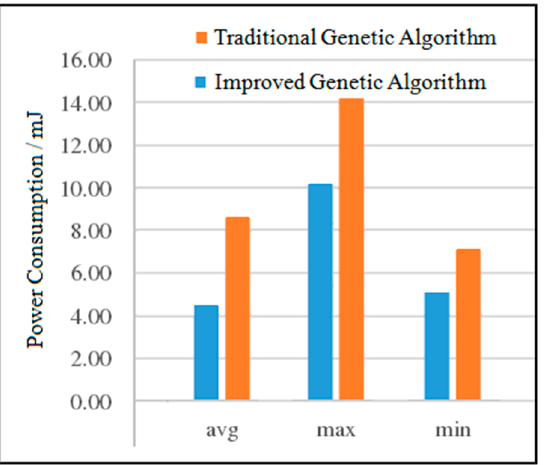
Figure 15. Comparison of the power consumption of the two algorithms for DVOPD.